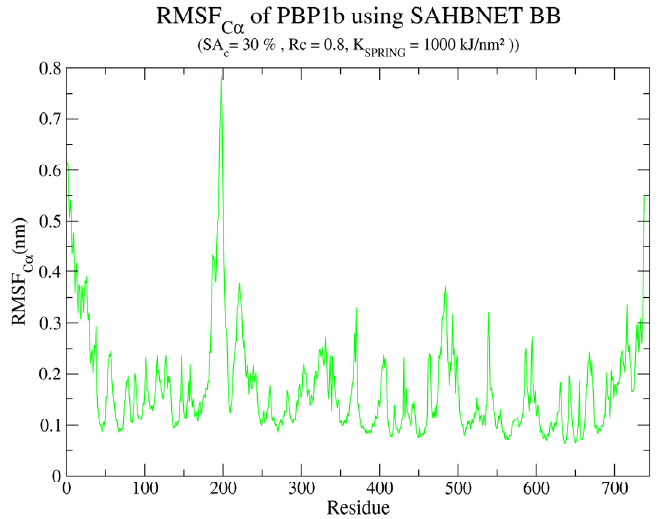
Figure 7. RMSF of the C α of the monotopic membrane protein PBP1b using SAHBNET BB (SA = 30%, R = 0.8 nm and K 1000 kJ/nm 2 c c SPRING